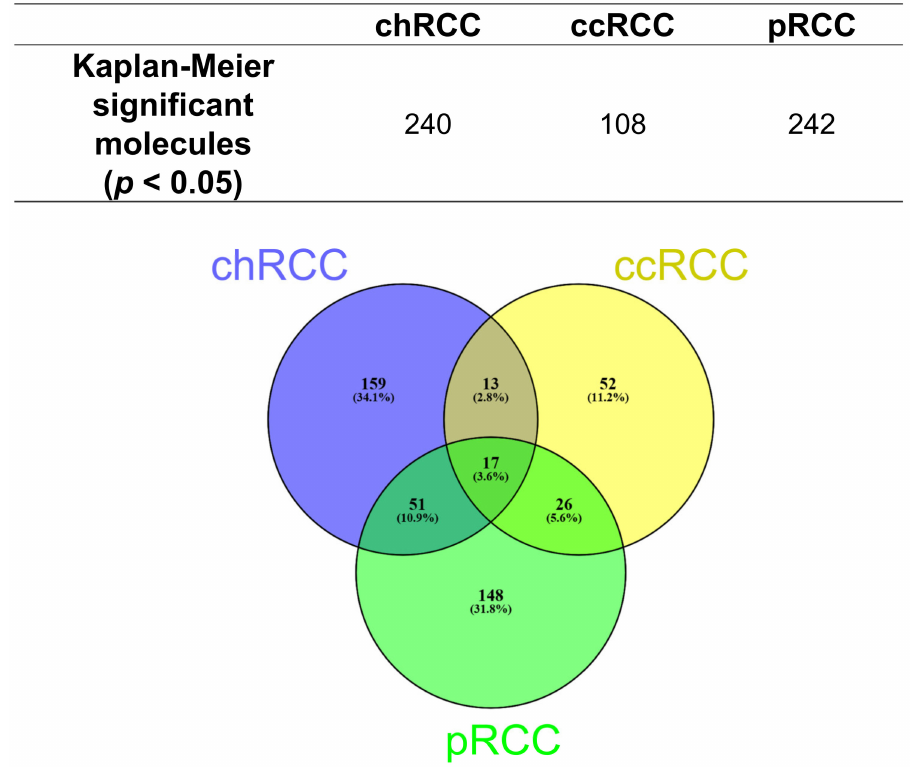
Figure 1. Kaplan–Meier significant metabolites in chRCC, pRCC and ccRCC.